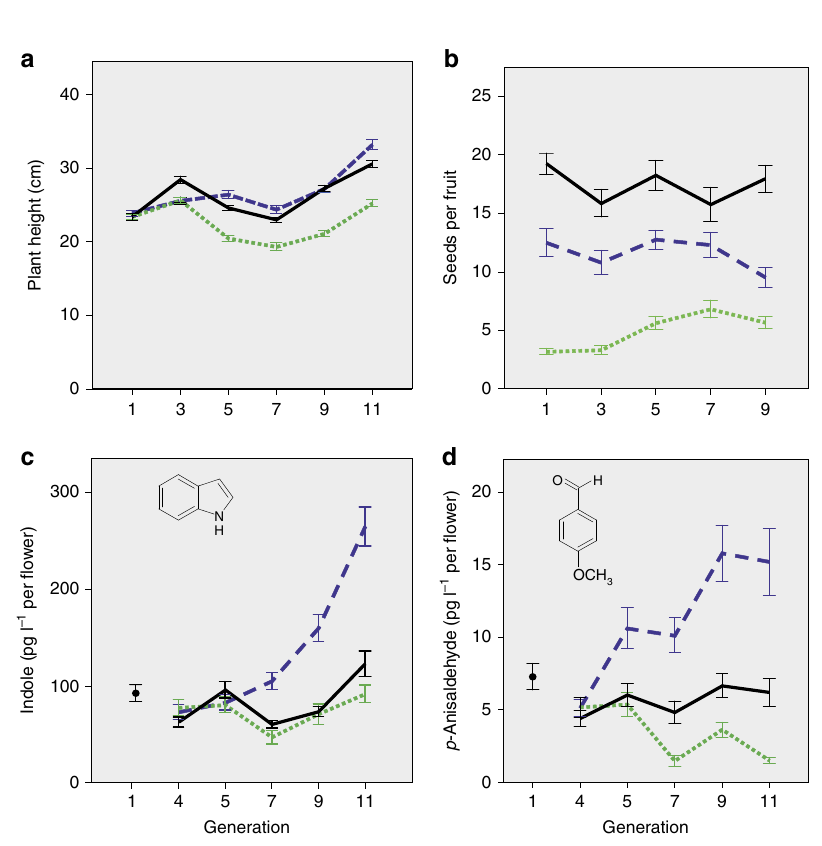
Figure 2 | Evolutionary changes in plants throughout experimental evolution. The figure shows mean ( ± s.e.m.) values per generation in the different pollinator-treatment groups (bumblebees: dashed blue, hoverflies: dotted green, control: solid black; sample sizes are between 82 and 108 per treatment and generation). ( a ) Plant height increased in bumblebee-pollinated plants. ( b ) Pollination efficiency (seeds per fruit) was initially low in hoverfly-pollinated plants but increased throughout the experiment. ( c ) The amount of indole and ( d ) p-anisaldehyde dramatically increased in bumblebee-pollinated plants; p -anisaldehyde decreased in hoverfly plants (see also Table 1; Supplementary Table 2).